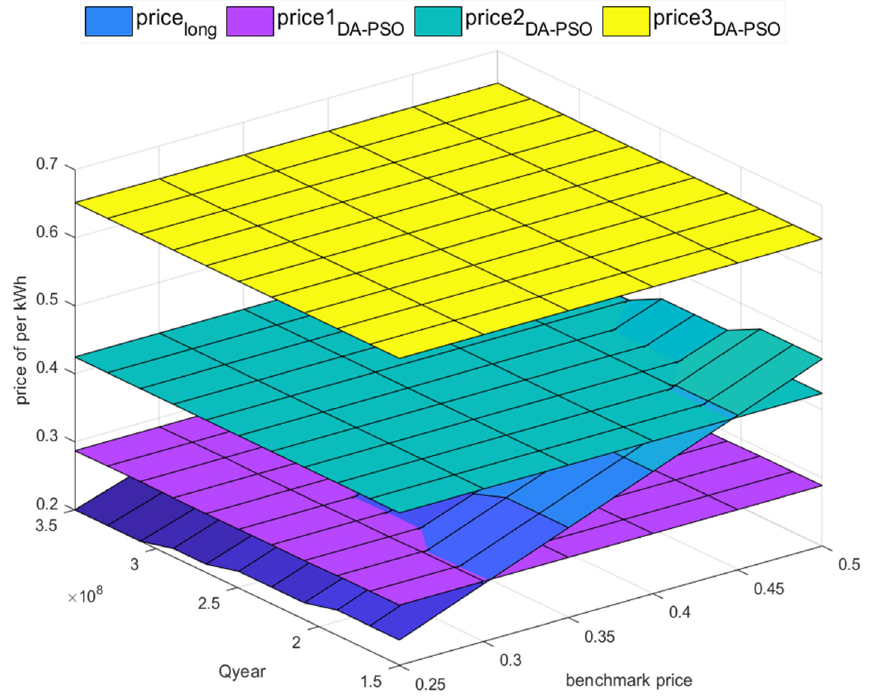
Figure 26. Relationship between the EKC of PSO decomposition and the long-term electricity price based on different DA prices in spot markets .